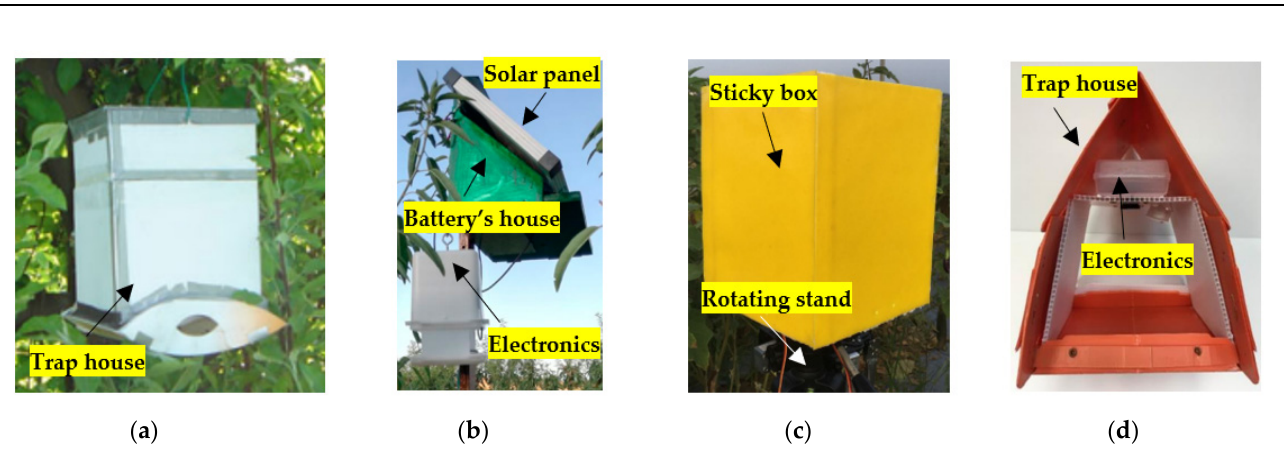
Figure 3. Prototype traps: ( a ) [22–25]; ( b ) [26]; ( c ) [27]; ( d ) [21].